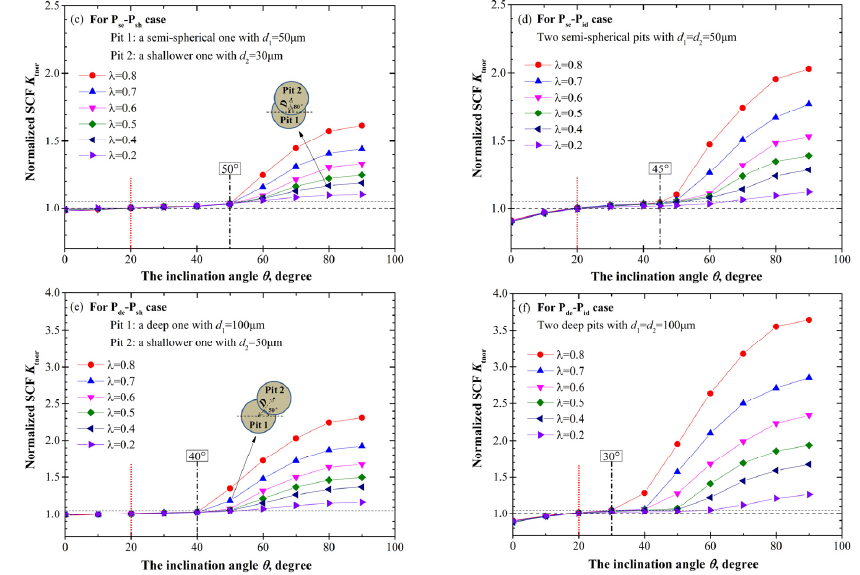
Figure 3. The variation of K tnor with the relative position parameters λ and θ for two intersecting pits.